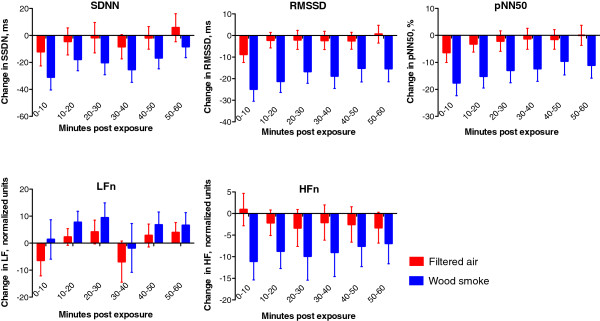
Heart rate variability recordings in 10 min intervals 0-60 minutes post exposure. Compared to filtered air, wood smoke exposure decreased the HF domain (p = 0.009), and a small decrease was seen in the LF domain (p = 0.086). All the time domain recordings were reduced following wood smoke exposure as compared to filtered air; SDNN (p = 0.003), RMSSD (p < 0.001) and pNN50 (p < 0.001). All data expressed as mean ± standard error of the mean and P-values from 2-way ANOVA with repeated measures.